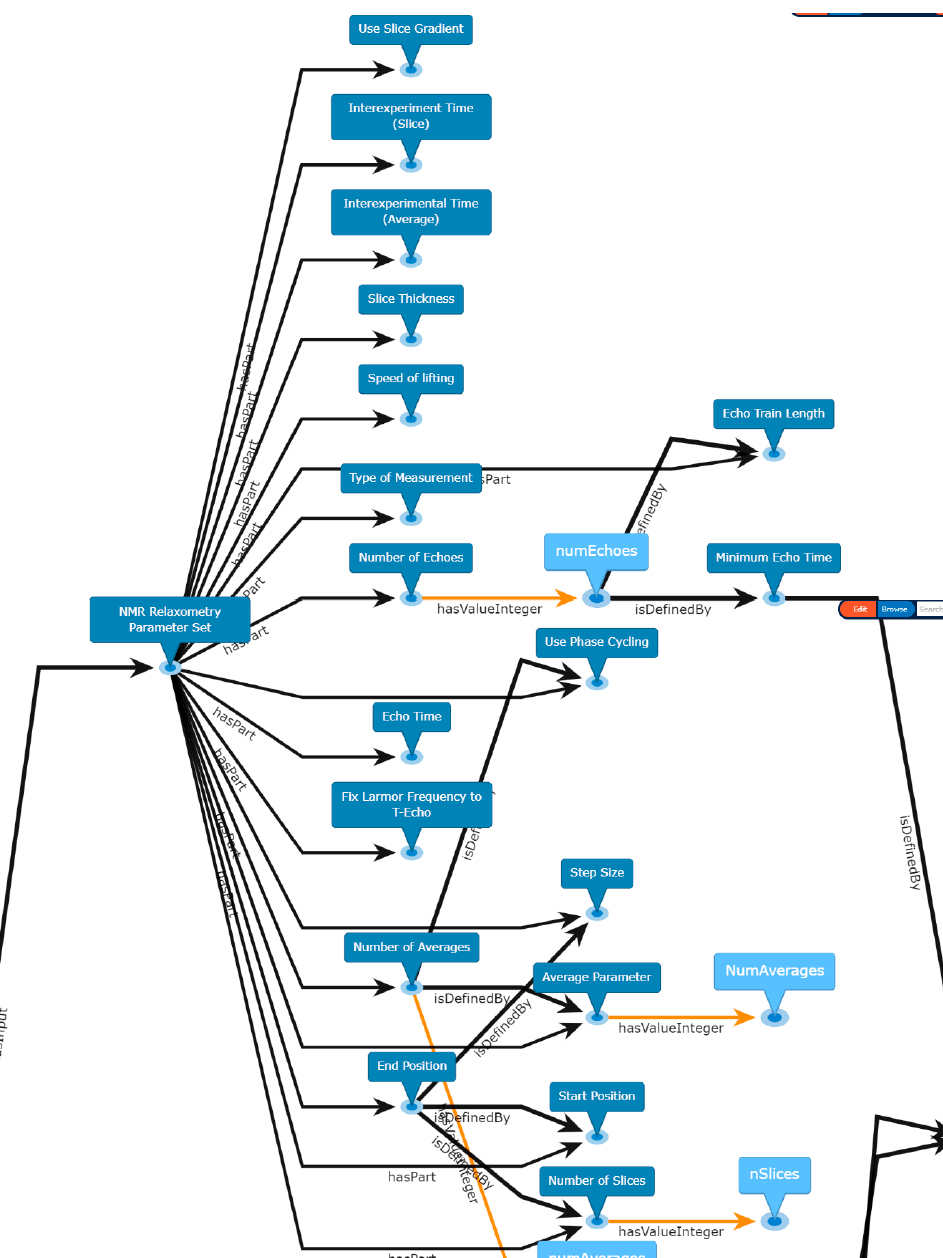
Figure A1. Zoom on Figure 9 Area 1: Description of the content in the metadata file.